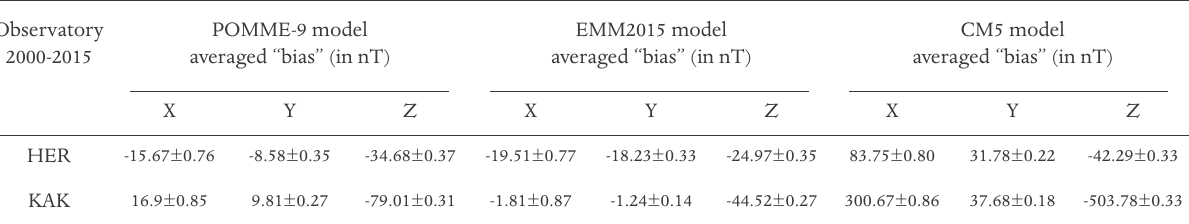
Table 3. Averaged “bias” at HER and KAK observatories.